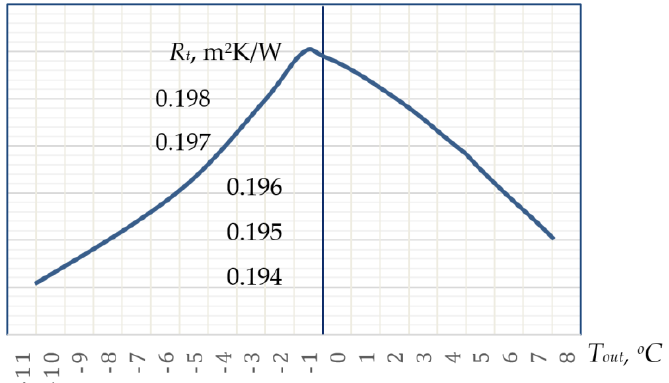
Figure 3. Dependence of the thermal resistance of a double-glazed window on changes in external temperature.